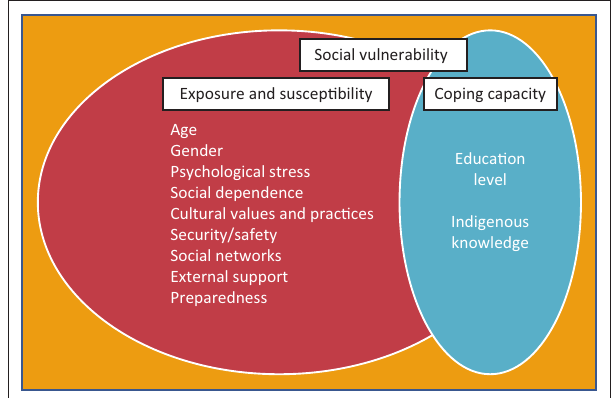
FIGURE 2: Summary of indicators using the BBC conceptual